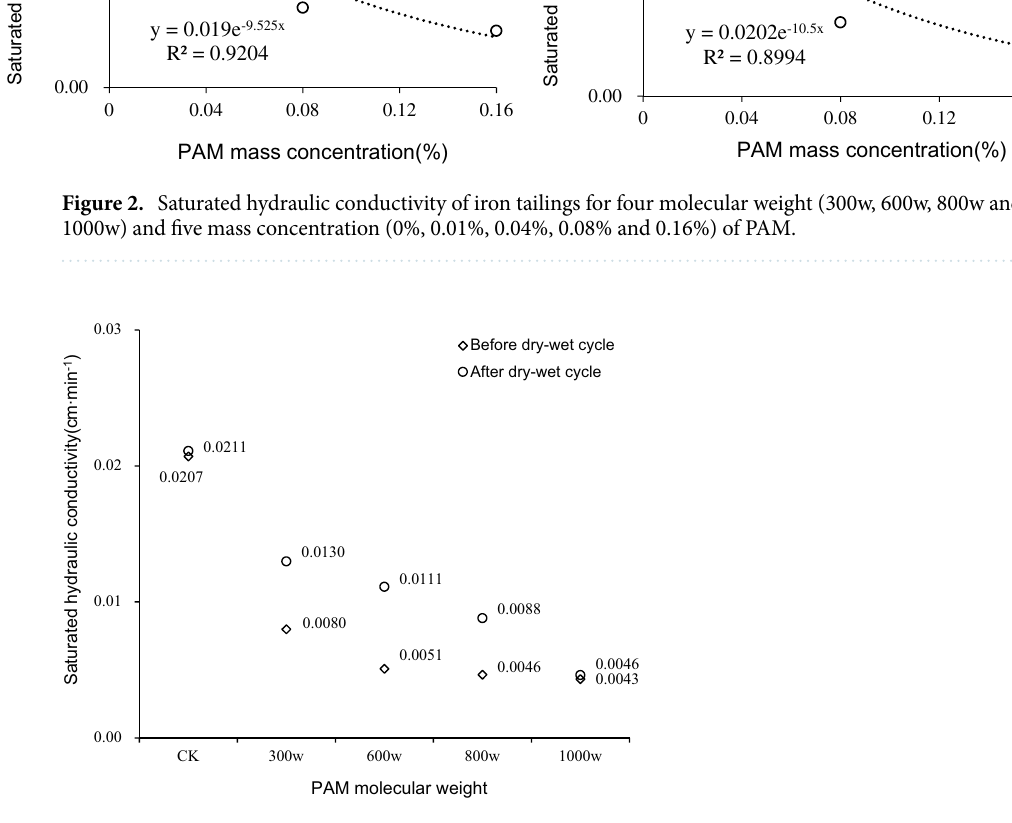
Figure 3. Saturated hydraulic conductivity of iron tailings under a dry–wet cycle for four molecular weight (300w, 600w, 800w and 1000w) and five mass concentration (0%, 0.01%, 0.04%, 0.08% and 0.16%) of